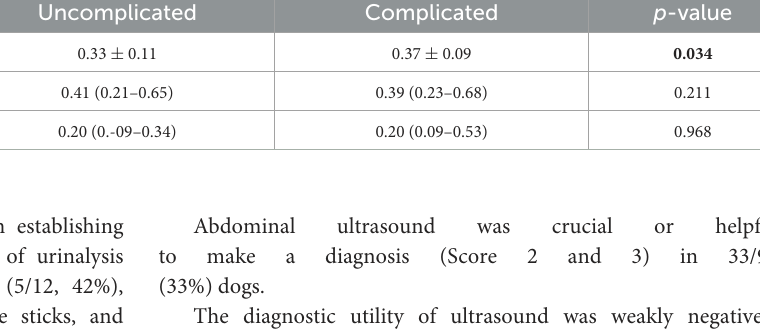
TABLE 6 Comparison of ultrasonographic intestinal wall thickness in 34 dogs with uncomplicated vomiting and 65 dogs with complicated vomiting. Parameter